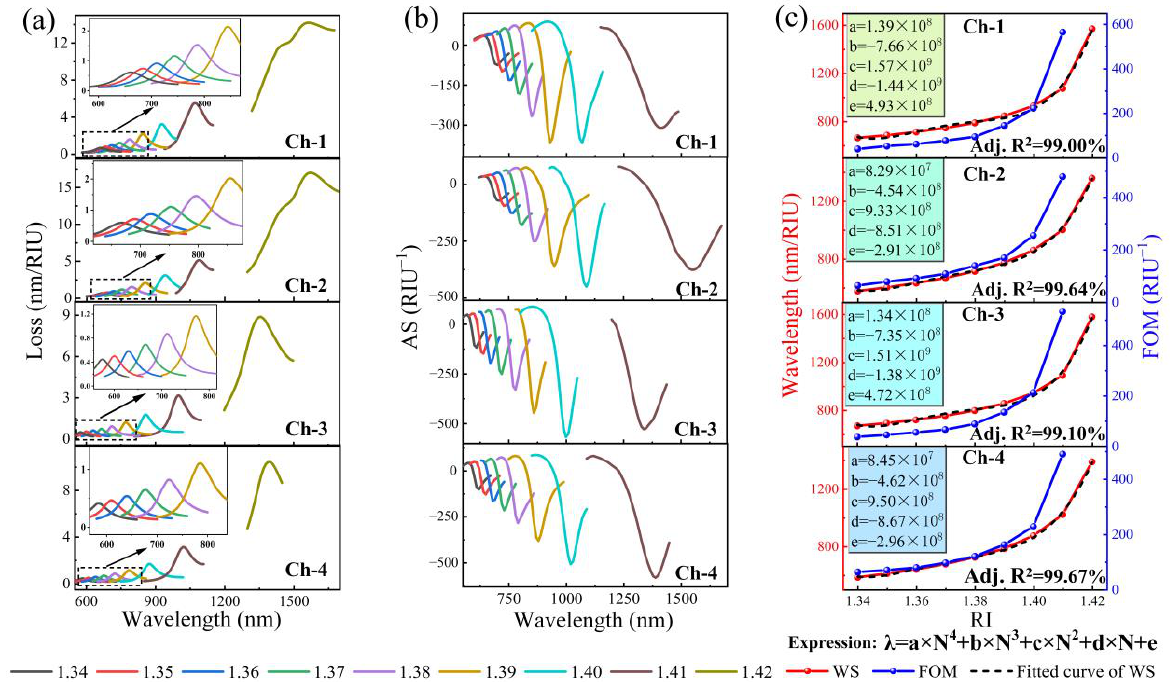
Figure 6. Variation of loss curves for introducing 0 to 2 layers of graphene on the metal surface of Ch-2 and Ch-4.